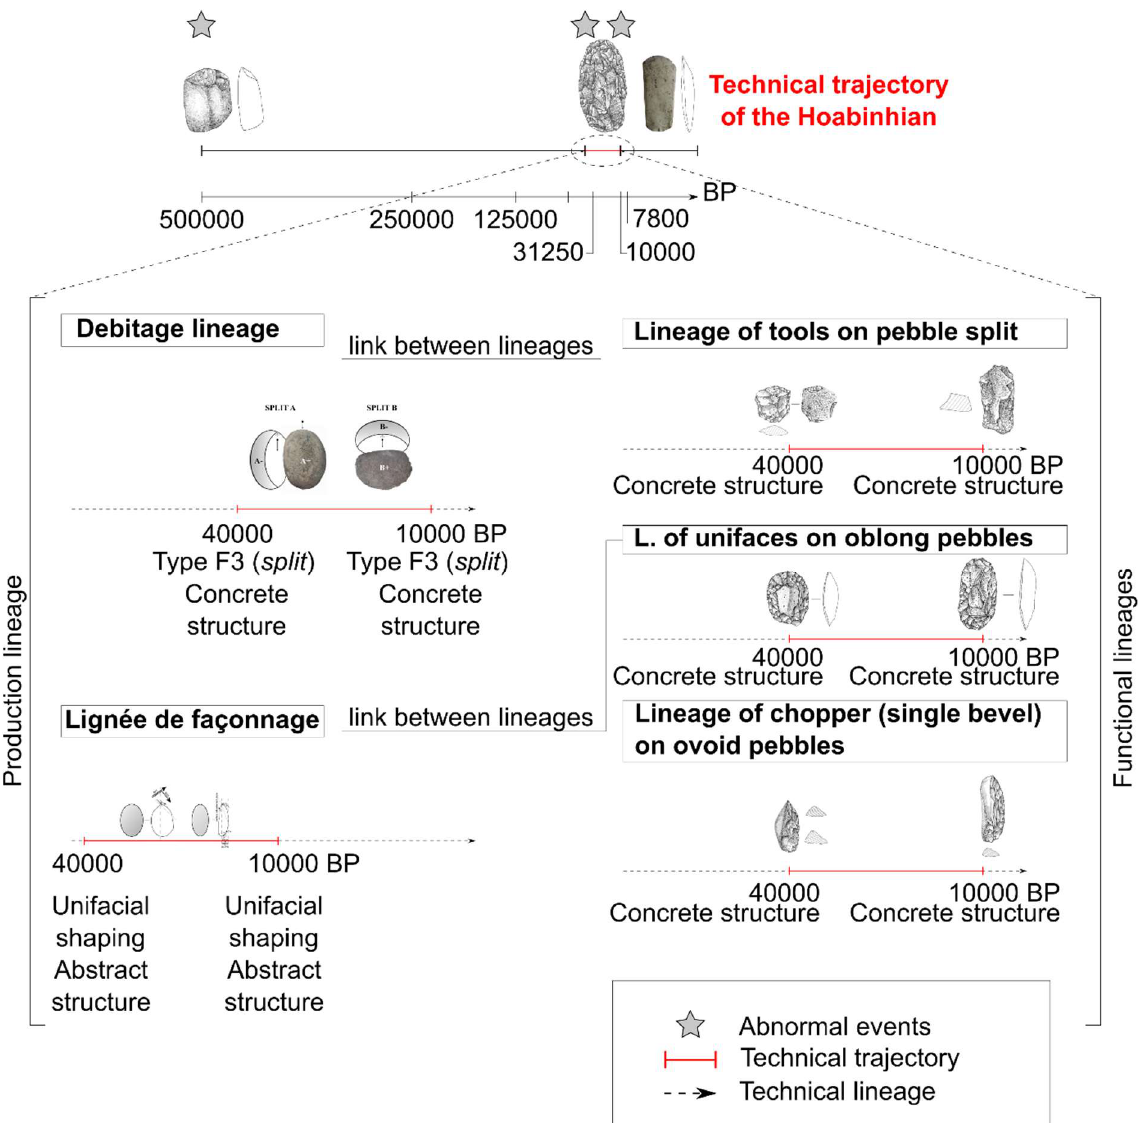
Figure 16. Example of technical trajectory, the case of Hoabinhian culture in Southeastern Asia (elaborated from Forestier, 2020a: